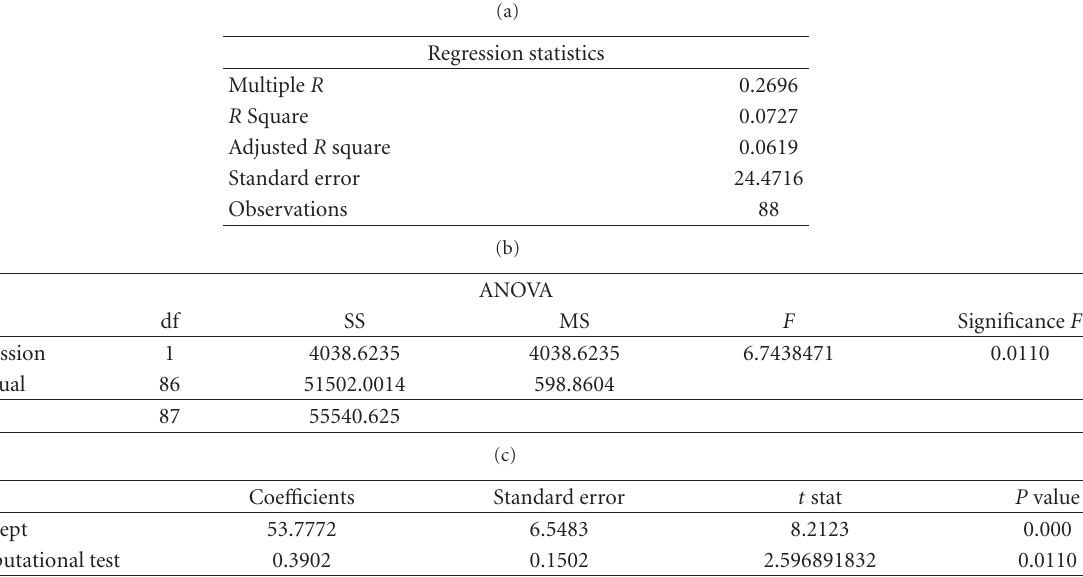
Table 3: Model development versus computational